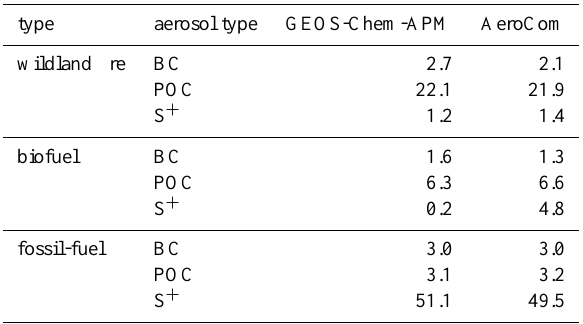
Table 2. Anthropogenic aerosol emissions based on GEOS-Chem- APM and comparison with AeroCom. Unit: Tg Syr − 1 for sulfur (S + ) , Tg Cyr − 1 for BC and POC.